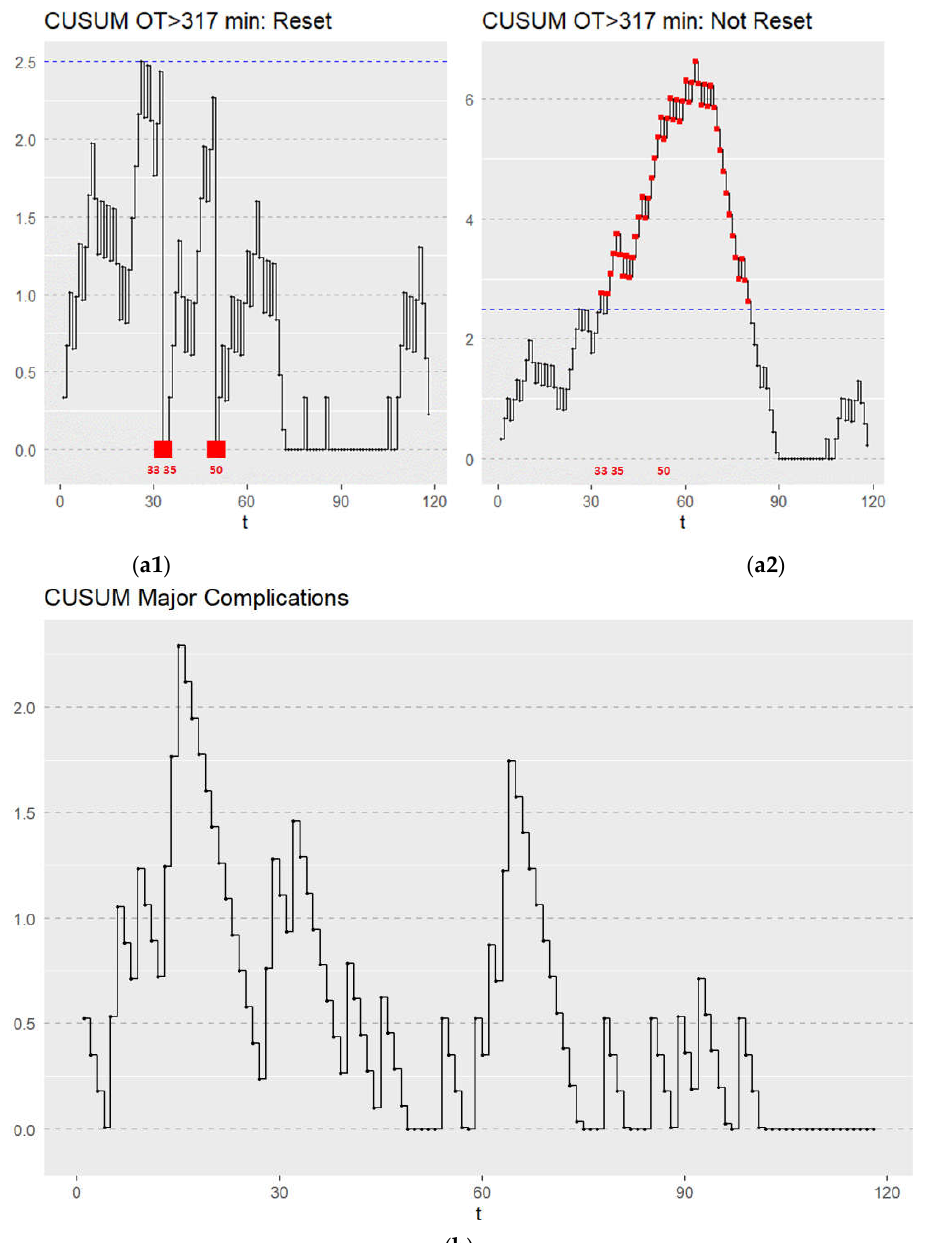
Figure 3. ( a1 ) CUSUM graph depicting the surgical learning curve for LTG in terms of OT. Failure was defined as an OT > 317 min. CUSUM OT > 317 min triggered a signal at 33, 35, and 50 patients. All CUSUM runs were initiated with C0 = 0 and reset Ct to zero after every alarm. The upper control limit is depicted by the blue dotted line. Points which triggered a signal are marked with a red point. ( a2 ) CUSUM graph depicting the surgical learning curve for LTG in terms of OT. Failure was defined as an OT >317 min. Initially increasing values of Ct leveled off after the fiftieth OT case and then decreased with increased learning. t—sequential hand-assisted laparoscopic gastrectomy performed. The upper control limit is depicted by the blue dotted line. Points which triggered a signal are marked with a red point. ( b ) CUSUM graph depicting the surgical learning curve for LTG in terms of major complications (CD 3–5), t—sequential hand-assisted laparoscopic gastrectomy performed.